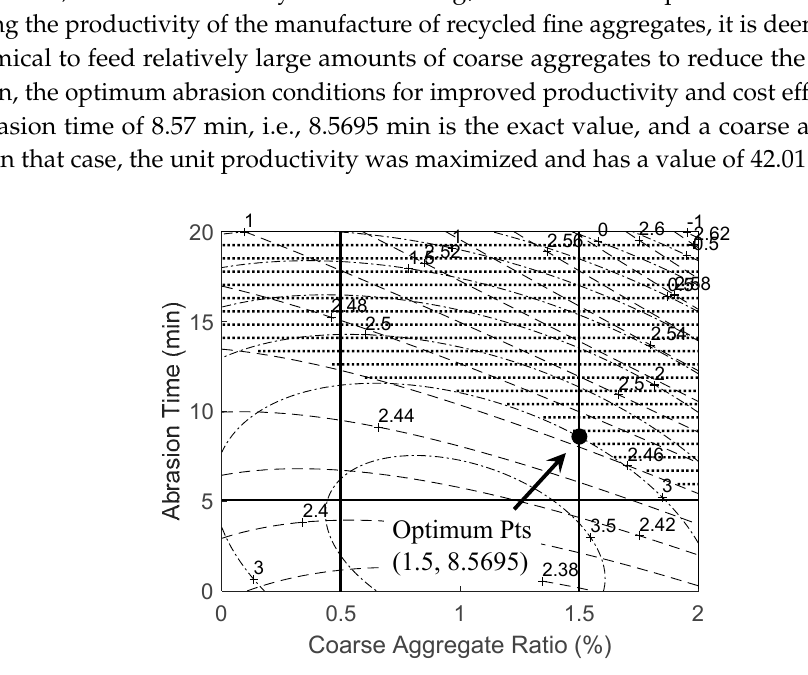
Figure 8. The optimum condition for improved quality of recycled fine aggregate.